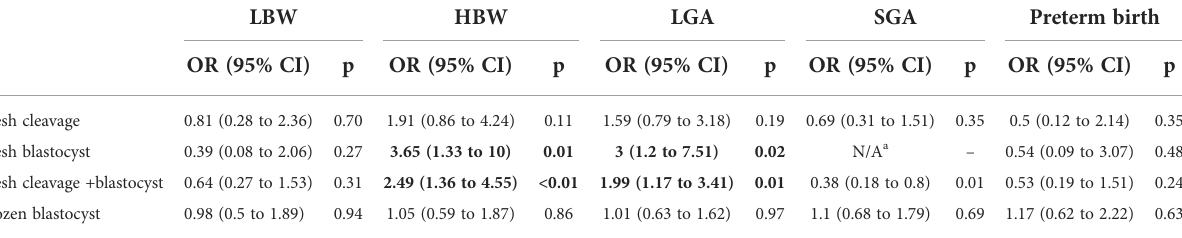
Modelswereadjustedformaternalage,BMI,parity,peakestradiollevel,endometrialthickness,inseminationprotocol(IVForICSI),femaleetiologies(tubalfactor,endometriosis),orderof transfer (1 or >1), mode of delivery (vaginal or Cesarean), and year of treatment. OR, odds ratio comparing embryos with day-3 fragmentation ≥ 10% vs. embryos with day-3 fragmentation <10%. a Data were unavailable because no event was observed. LBW, low birth weight; HBW, hight birth weight; LGA, large for gestational age; SGA, small for gestational age, CI, con fi dence interval. The bold values indicate signi fi cant at